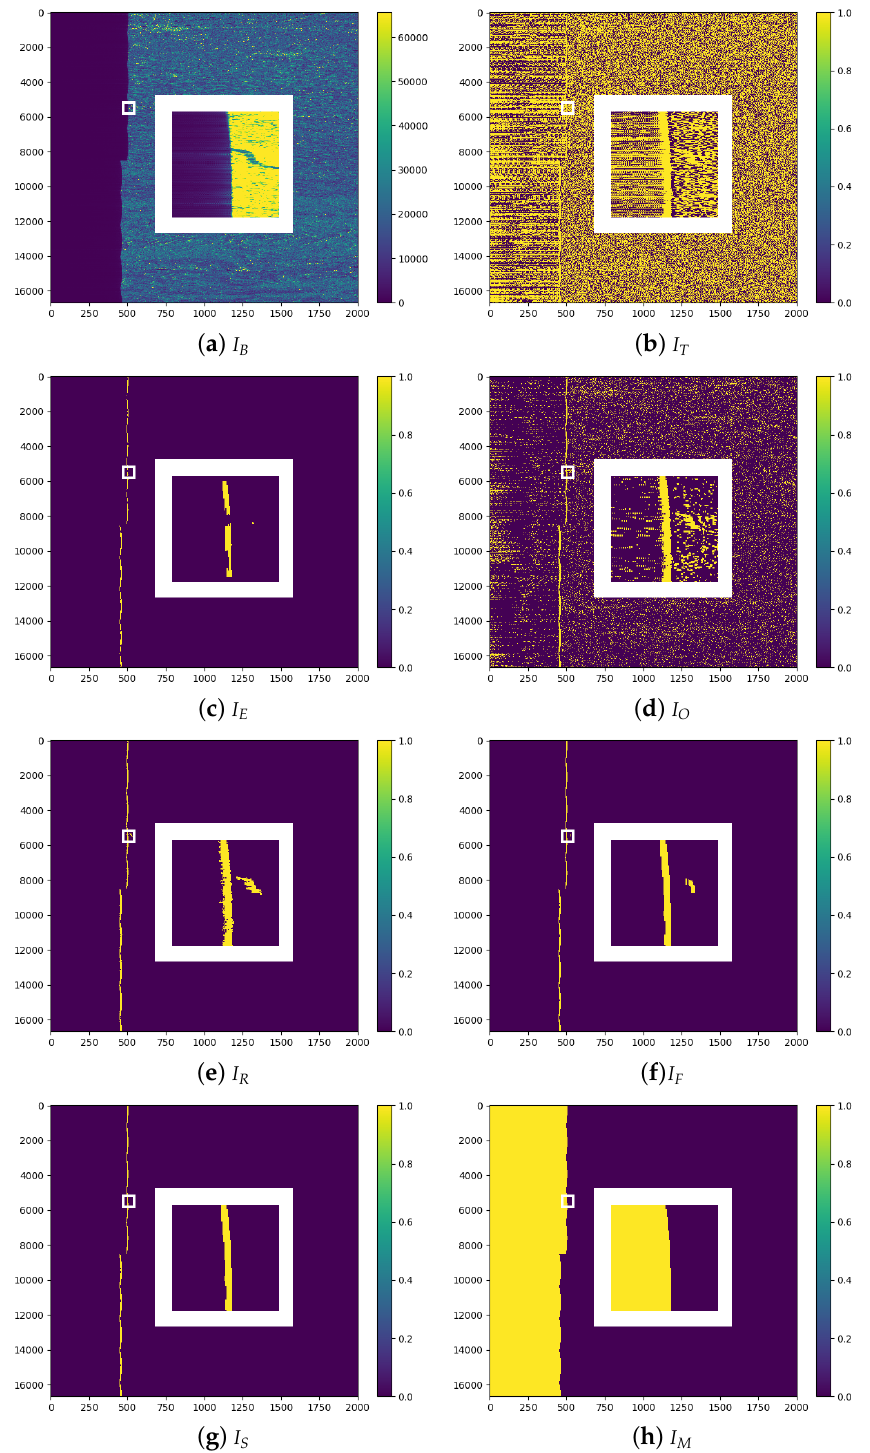
Figure 3. Border noise masking processing steps (overall image and inner white frame showing the close-up of a smaller area around the border noise interface): ( a ) clipping of the input image around the border noise edge; ( b ) adaptive thresholding to detect local discontinuities; ( c ) generation of a marker image containing only the border noise/data interface (BDI) pixels; ( d ) generation of a mask image to better define the BDI outline; ( e ) reconstruction by dilation of the mask image using the marker pixels as seeds; ( f ) refinement of the BDI outline through a combination of an opening and a closing ; ( g ) removal of outliers; ( h ) final border noise mask in